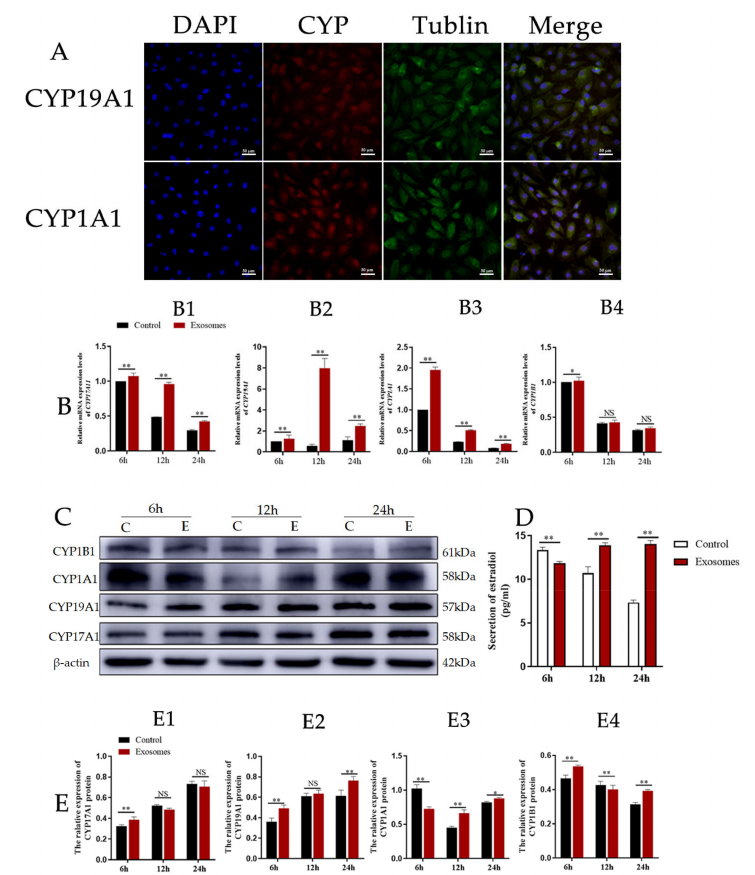
Figure 5. Yak follicular fluid exosomes could increase 2-OHE 2 secretion in YCCs. ( A ) Immunofluores- cence staining of CYP19A1 and CYP1A1 proteins in YCCs. Scale bar represents 50 µ m. ( B ) Expression of 2-OHE 2 secretion-related genes CYP17A1 ( B1 ), CYP19A1 ( B2 ), CYP1A1 ( B3 ) and CYP1B1 ( B4 ) in YCCs using the qPCR assay. ( C ) Western blot analysis of the protein expression in YCCs (C: Control, E: Yak follicular fluid exosomes) (See Figure S2). ( D ) ELISA kit analyses of the concentrations of estradiol (pg/mL) in the cell supernatant. ( E ) Quantitative Western blot results for CYP17A1 ( E1 ), CYP19A1 ( E2 ), CYP1A1 ( E3 ) and CYP1B1 ( E4 ). Data are expressed as the mean ± SD. n = 6. NS means no significant difference. * p < 0.05 and ** p < 0.01 indicate significant differences between the yak follicular fluid exosome treatments and the